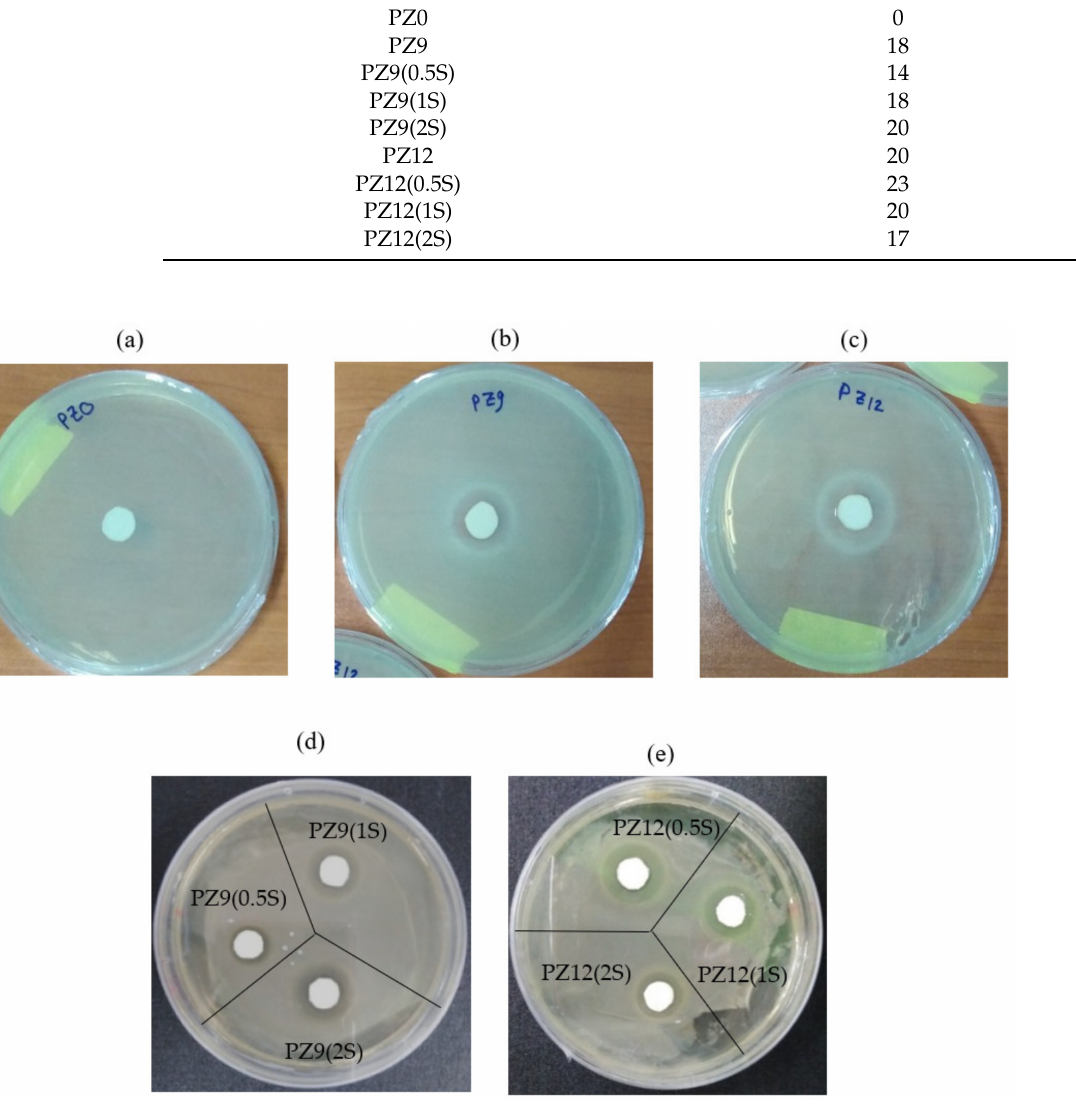
Figure 13. Zones of inhibition around ( a ) pure PAN nanofiber, ( b ) unmodified PZ9, ( c ) unmodified PZ12, ( d ) various PZ9(S) and ( e ) PZ12(S)